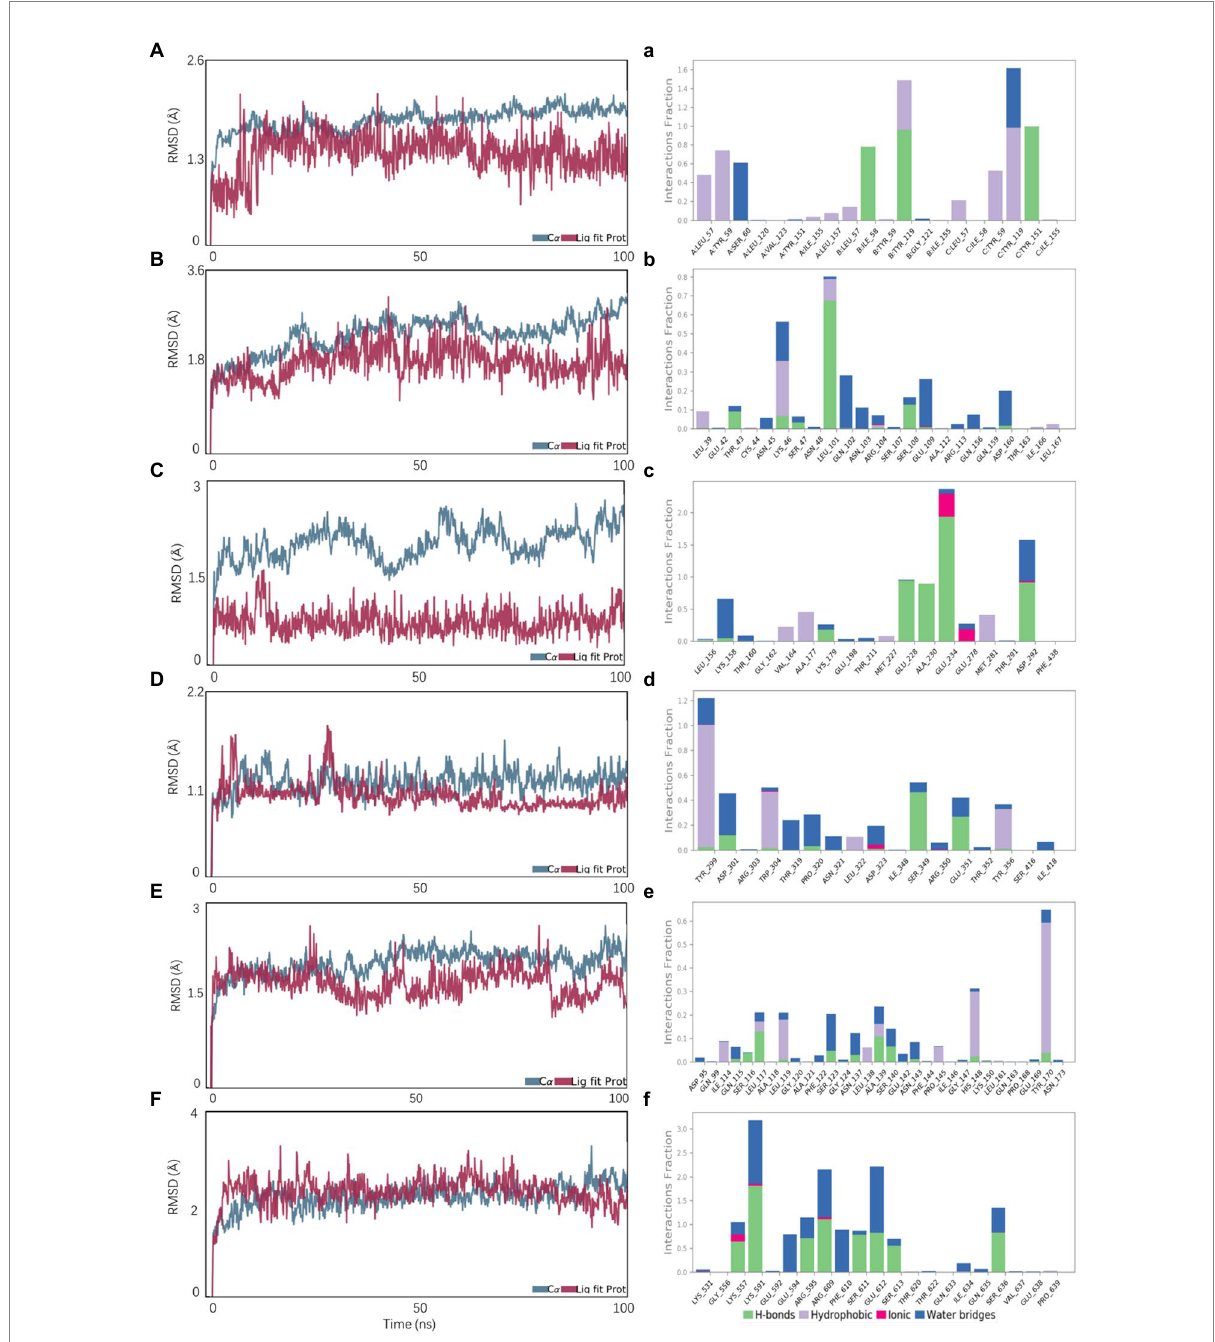
FIGURE 7 Molecular dynamics simulations. A, B, C, D, E, F represent the RMSD plot during molecular dynamics simulations of AKT1-ligand063, IL6-ligand121, STAT3-ligand113, TLR4-ligand103, TNF-ligand103, VEGFA-ligand073; a, b, c, d, e, f represent the interaction residues of AKT1-ligand063, IL6- ligand121, STAT3-ligand113, TLR4-ligand103, TNF-ligand103, VEGFA-ligand073.